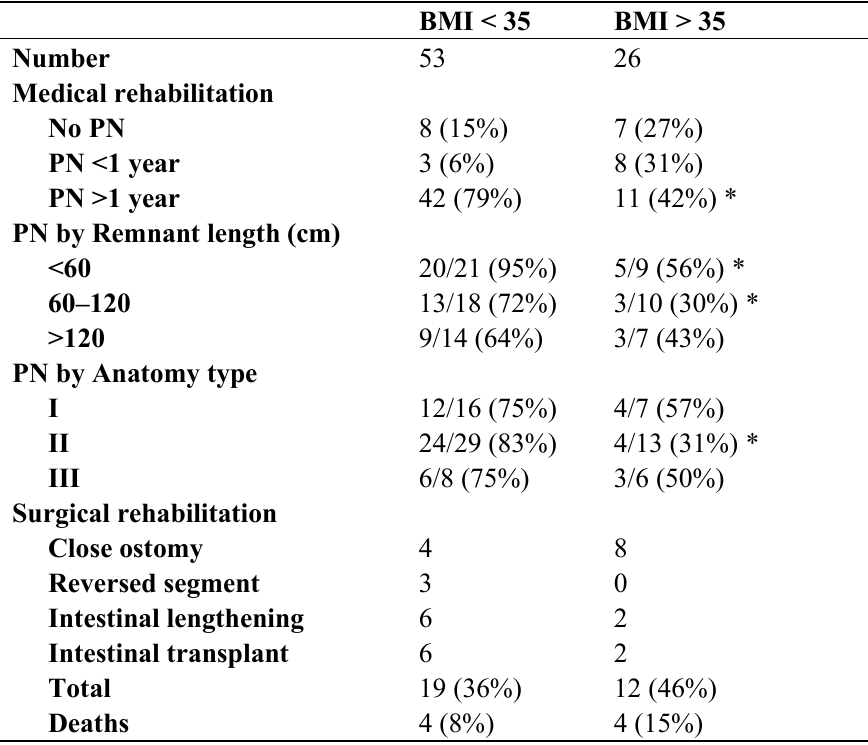
Table 3. Comparison of intestinal